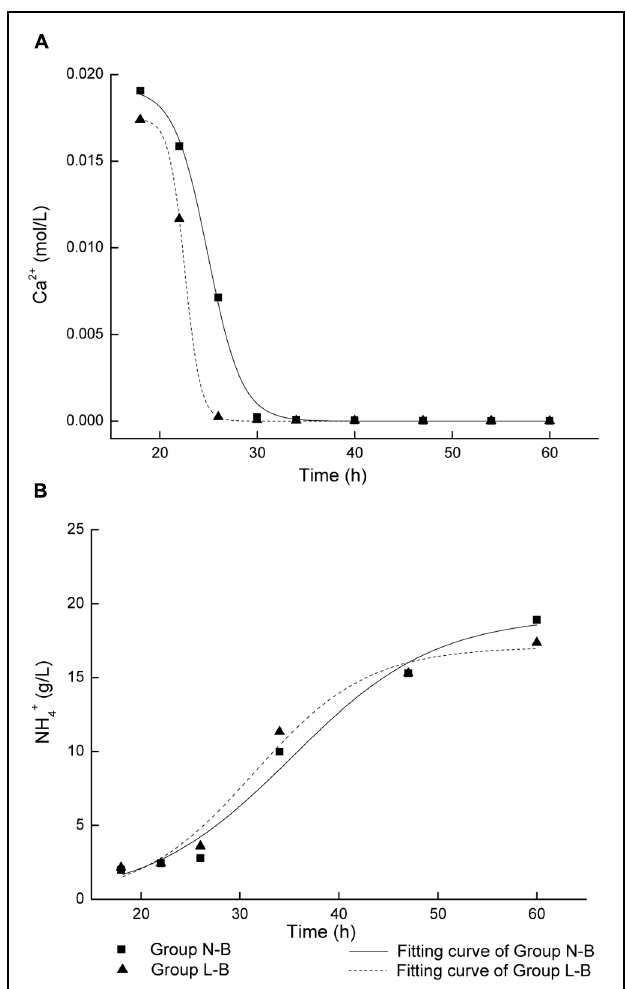
FIGURE 2 | Fitting of curves for microbiologically induced precipitation with live cells: (A) CaCO 3 precipitation; (B) NH 4 + production.